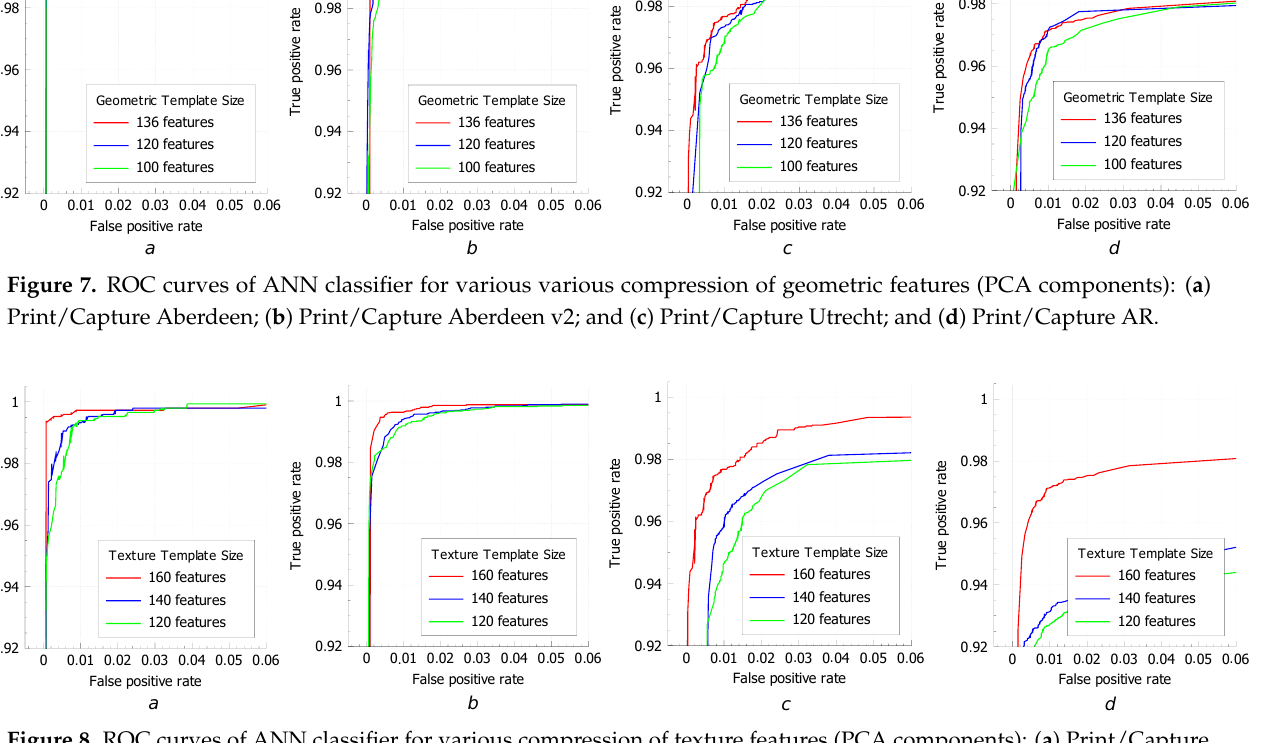
Figure 8. ROC curves of ANN classifier for various compression of texture features (PCA components): ( a ) Print/Capture Aberdeen; ( b ) Print/Capture Aberdeen v2; ( c ) Print/Capture Utrecht; and ( d ) Print/Capture AR.